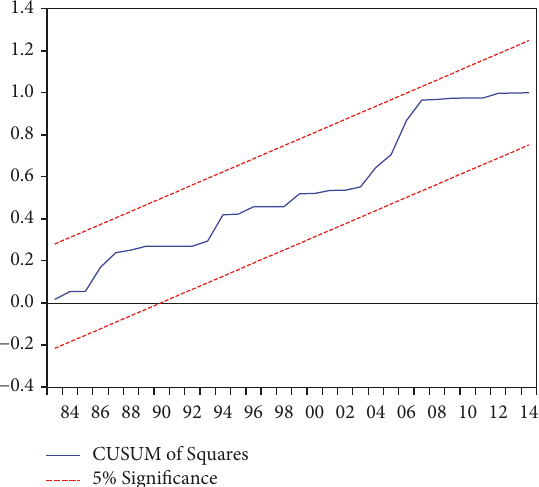
Figure 2: Cumulative sum of square recursive